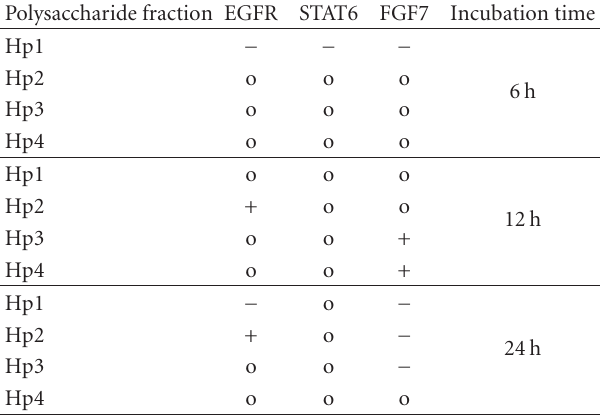
Table 5: Gene expression of NHDF after incubation with 10 μ g/mL St. John’s Wort polysaccharide fractions in minimal MEM for 6h, 12 h, and 24 h. Results of RT-PCR with TaqMan assays were normalized to endogenous control 18 srRNA and to the respected expression of target genes in untreated control cells. Regulation was defined as significant with > 2 (+) and < 0.5 ( − ). No change in gene expression is shown as